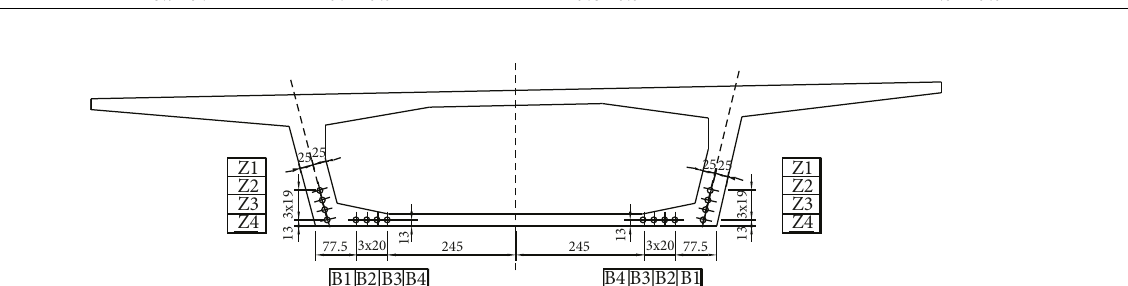
Figure 8: Prestress arrangement of the mid-span section (cm).